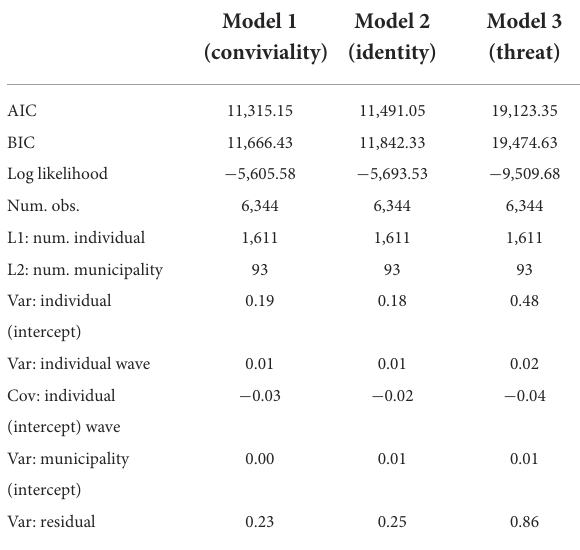
TABLE 8 Multilevel linear regression models with